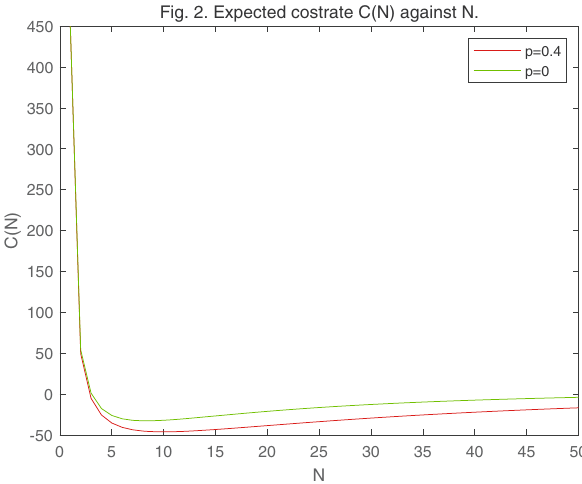
Fig. 2. Expected costrate C(N) against N.